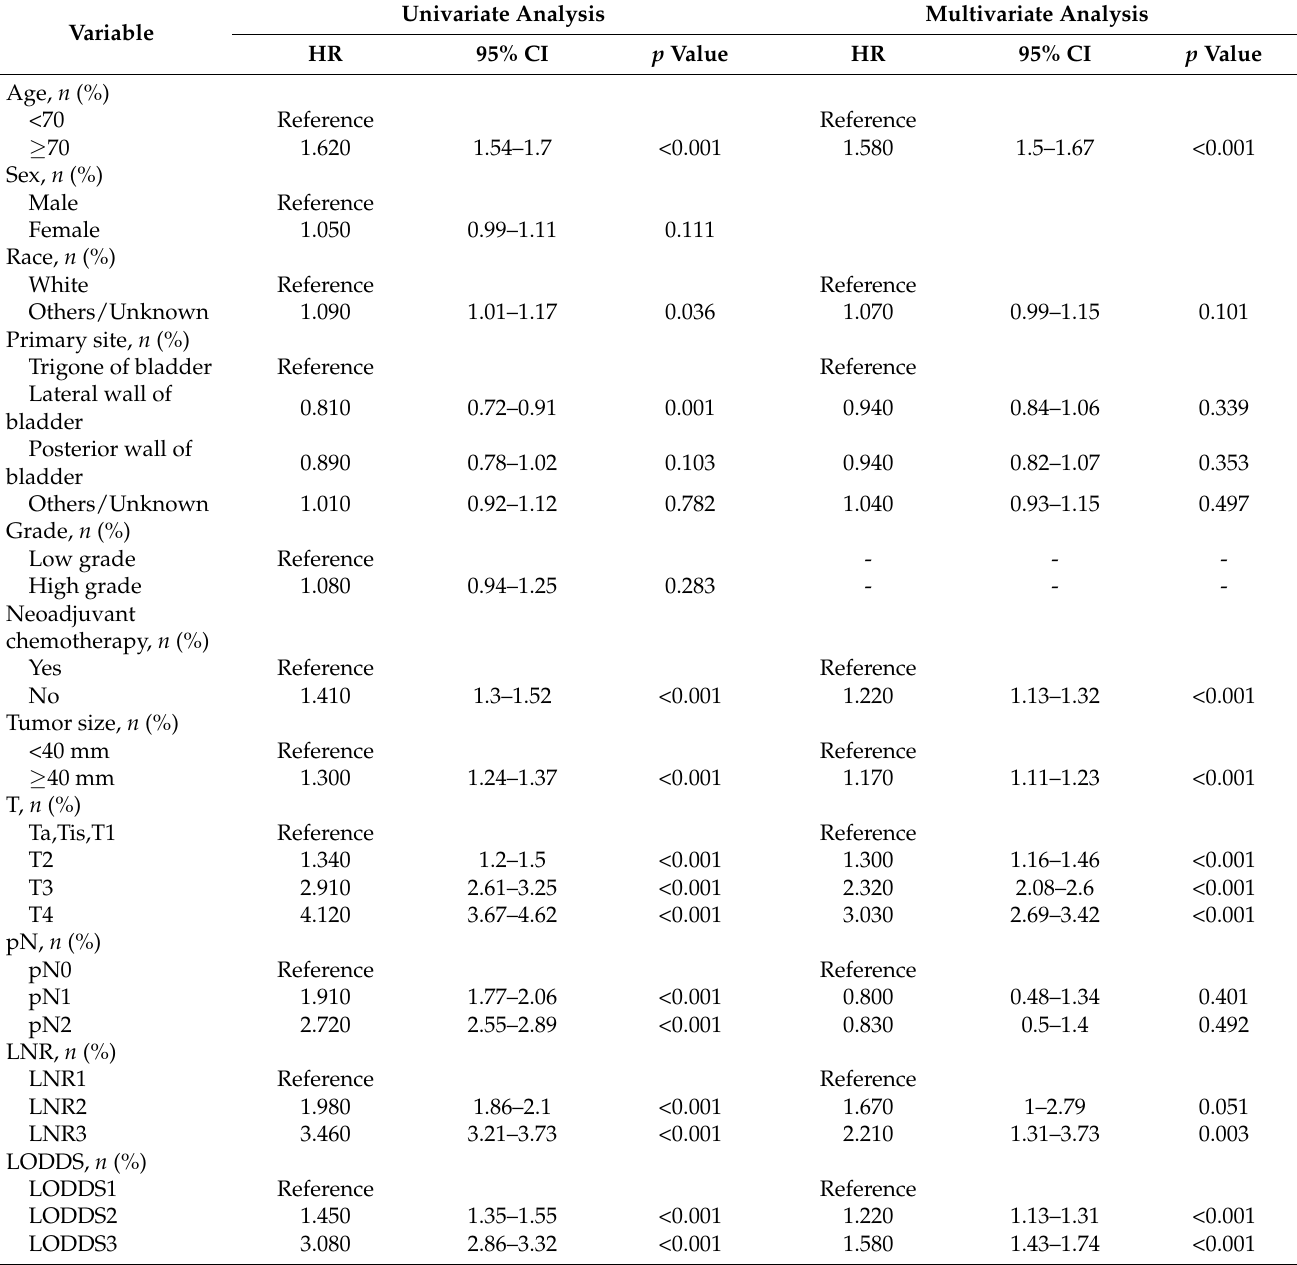
Table 2. Prognostic factors for overall survival of